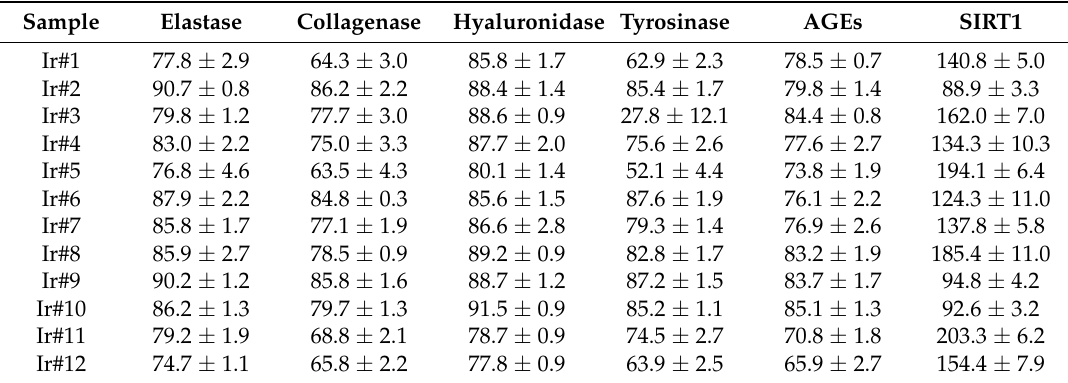
Table 4. Anti-aging activities of 12 I. rugosus callus sample extracts expressed as percentage activities of control (DMSO) (culture conditions of the callus are presented in Table